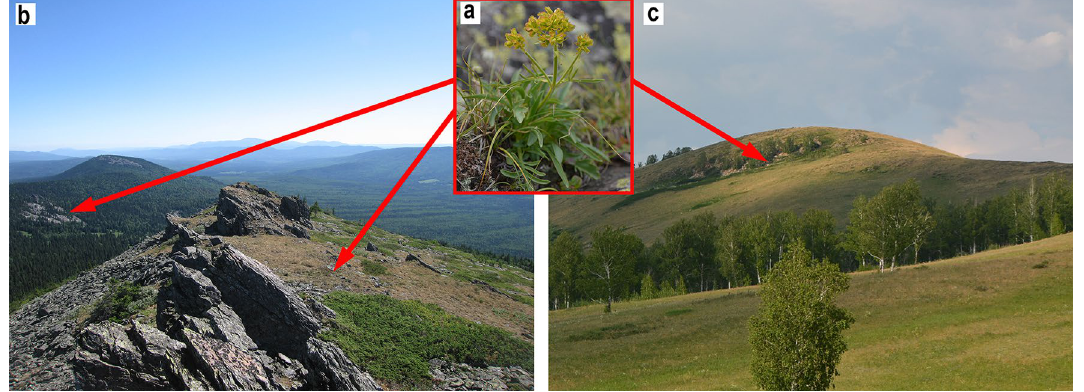
Figure 1. Patrinia sibirica ( a ) and its typical habitats in mountain forest ( b ) and mountain forest-steppe ( c ) zones.